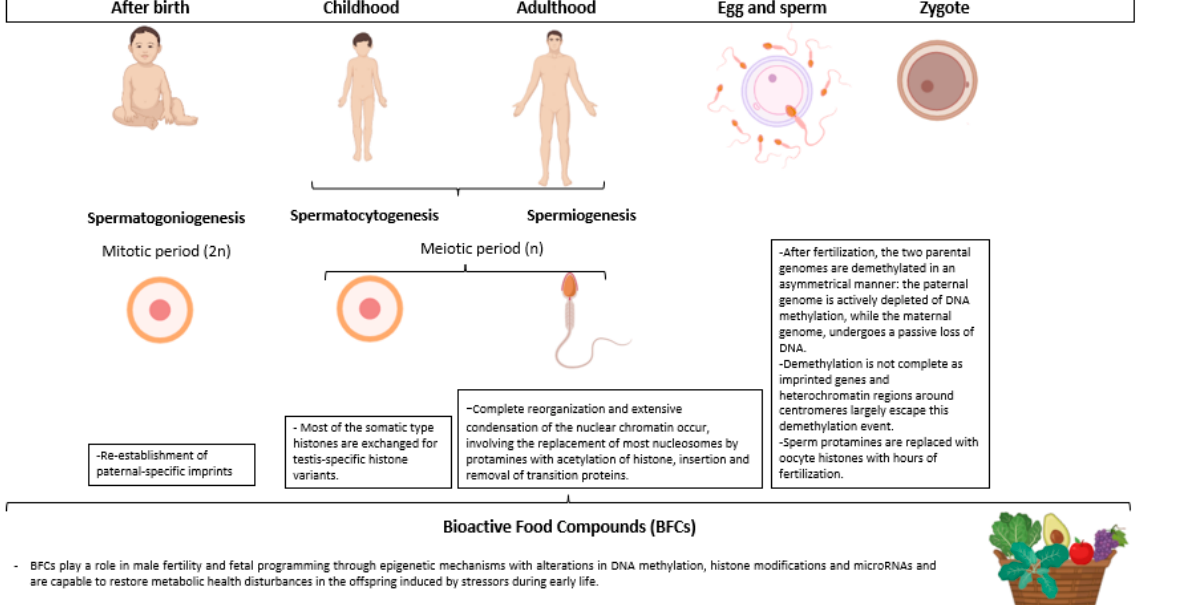
Figure 1. Consumption of BFCs as a potential epigenetic strategy to improve men’s reproductive health and prevent chronic disease risk in the offspring. Created with BioRender.com (accessed on 11 May